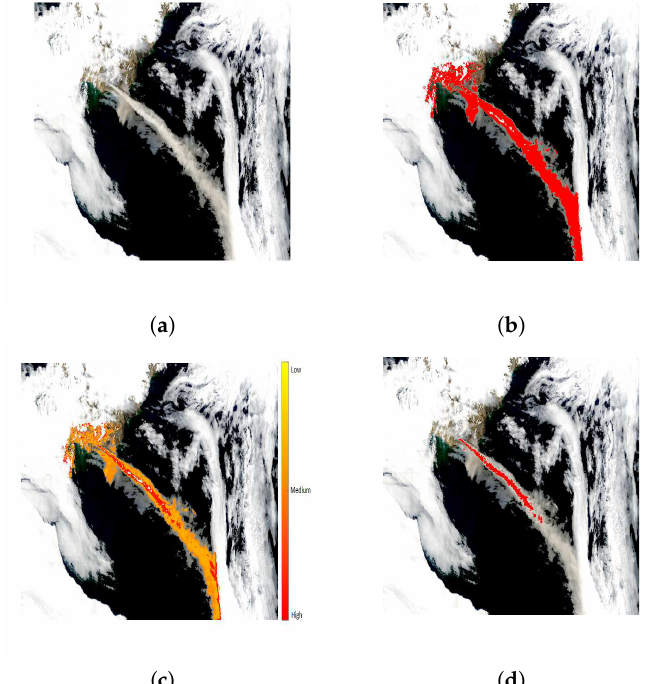
Figure 9. Results of ash monitoring from the Eyjafjallajökull Volcano eruption, Iceland, 2010. ( a ) Composed RGB MODIS image during the event. ( b ) Detection of volcanic ash based on spectral retrieval. ( c ) Ash cloud monitoring and relative concentration. ( d ) Temperature difference